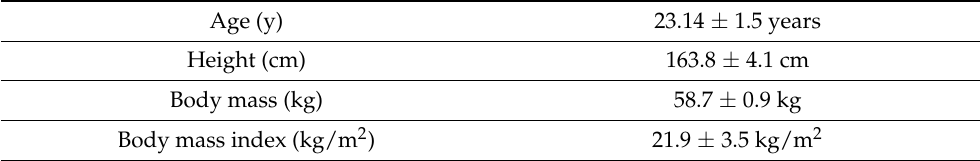
Table 2. Participant